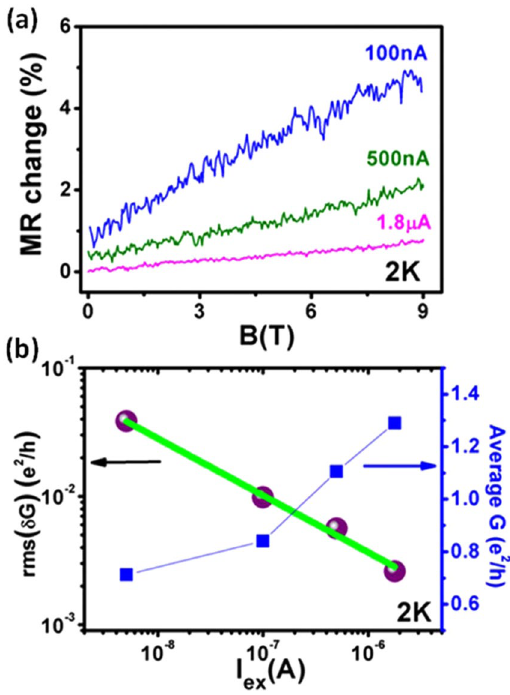
Figure 3. Current dependence of UCF for device W3. ( a ) M-R change (%) curves for different excitation currents at 2 K. A decrease in M-R fluctuations is observed with increasing excitation current. ( b ) Left panel shows the exponentially decreasing fluctuation amplitude with excitation current. Right panel shows the increase in average conductance with excitation